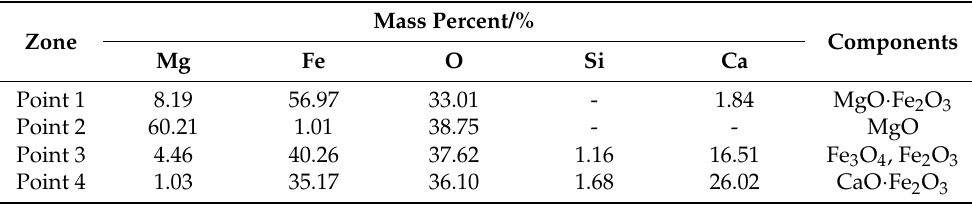
Figure 15. SEM analysis of Fe 2 O 3 -MgO-CaO sample after reduction. ( a ) 0% ( b ) 25% ( c ) 50% ( d ) 75% ( e ) 100%. Table 8. EDS analysis of Fe 2 O 3 -MgO-CaO sample after reduction.